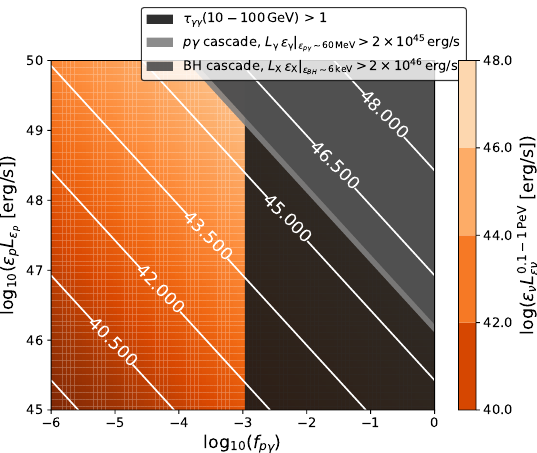
Figure 3. Same as figure 2 but for the 2014-15 IceCube archival , ε ν flare. , and the neutrino p 10 − 28 cm 2 , r (cid:48) is the comoving radius of the emitting blob, b n ε (cid:48) is the density of target photons of energy ε (cid:48) and ε (cid:48) the p t t comoving proton energy. Further, m p is the proton mass, and m π the pion mass. For TXS 0506 + 056 it was shown in [27] that β ∼ 2 . 8. The same photons are the target photons for γγ interactions. The relevant optical depth is related to the photo-meson production e ffi ciency, f p γ , via,